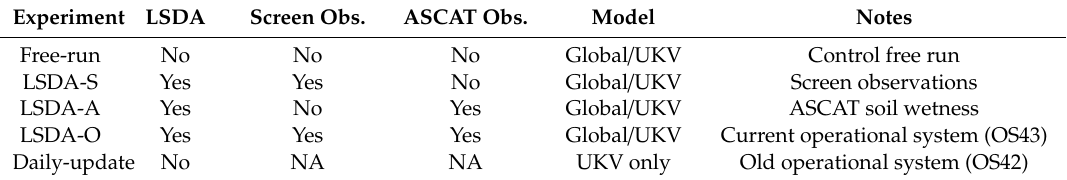
Table 1. Description of the experiments. Names of the experiments refer to the initialisation of soil moisture. Free-run has no Land Surface Data Assimilation (LSDA) and soil moisture is cycled. The su ffi x in the LSDA experiments represent the ingested observations: “S” for screen observations, “A” for ASCAT and “O” (i.e., operations) ingests both S and A. Daily-update (UKV-only) is similar to the Free-run, but the soil moisture is initialised from the global soil moisture analysis at the 09Z cycle. Experiment LSDA Screen Obs. ASCAT Obs. Model Notes Global / UKV Screen observations Global / UKV Global / UKV Current operational system (OS43) NA NA UKV